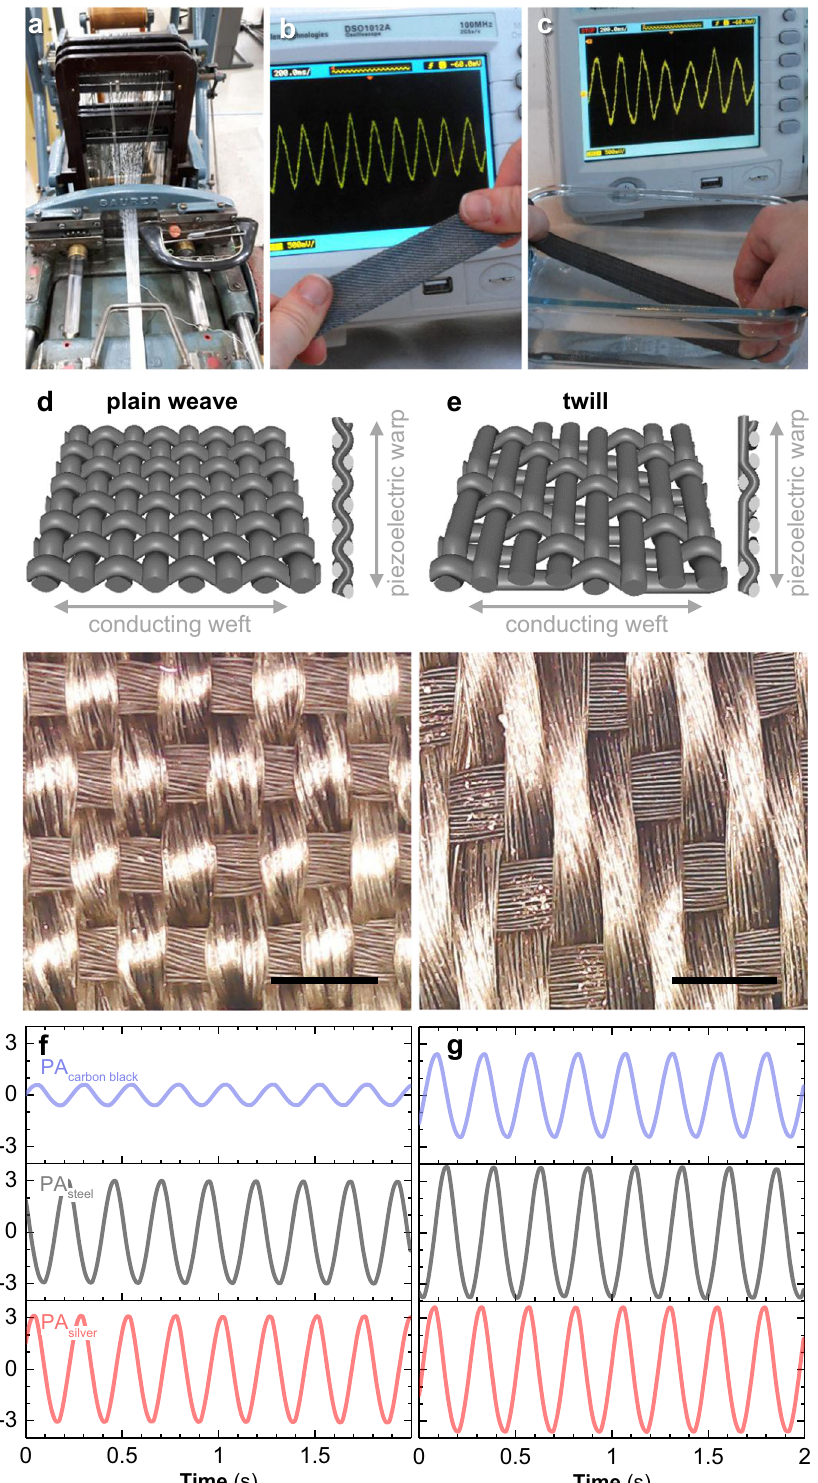
Fig. 3 Manufacture and piezoelectric behaviour of woven bands. a Photograph of the band weaving machine used for production of the piezoelectric textiles. Photographs of the textile bands ( b : dry; c : submerged in water) when stretched by hand: the output voltage is shown on the oscilloscope screen. Schematics (top) and photographs (bottom, scale bars are 1 mm) of produced ( d ) plain weave and ( e ) twill textile architectures; the warp consists of piezoyarns, the weft of conducting yarns (photos: PA carbon black ). Generated piezoelectric voltage of f plain weave and g twill textiles at f = 4 Hz and ε = 0.25%: outer electrodes are PA carbon black (blue), PA steel (grey), and PA silver